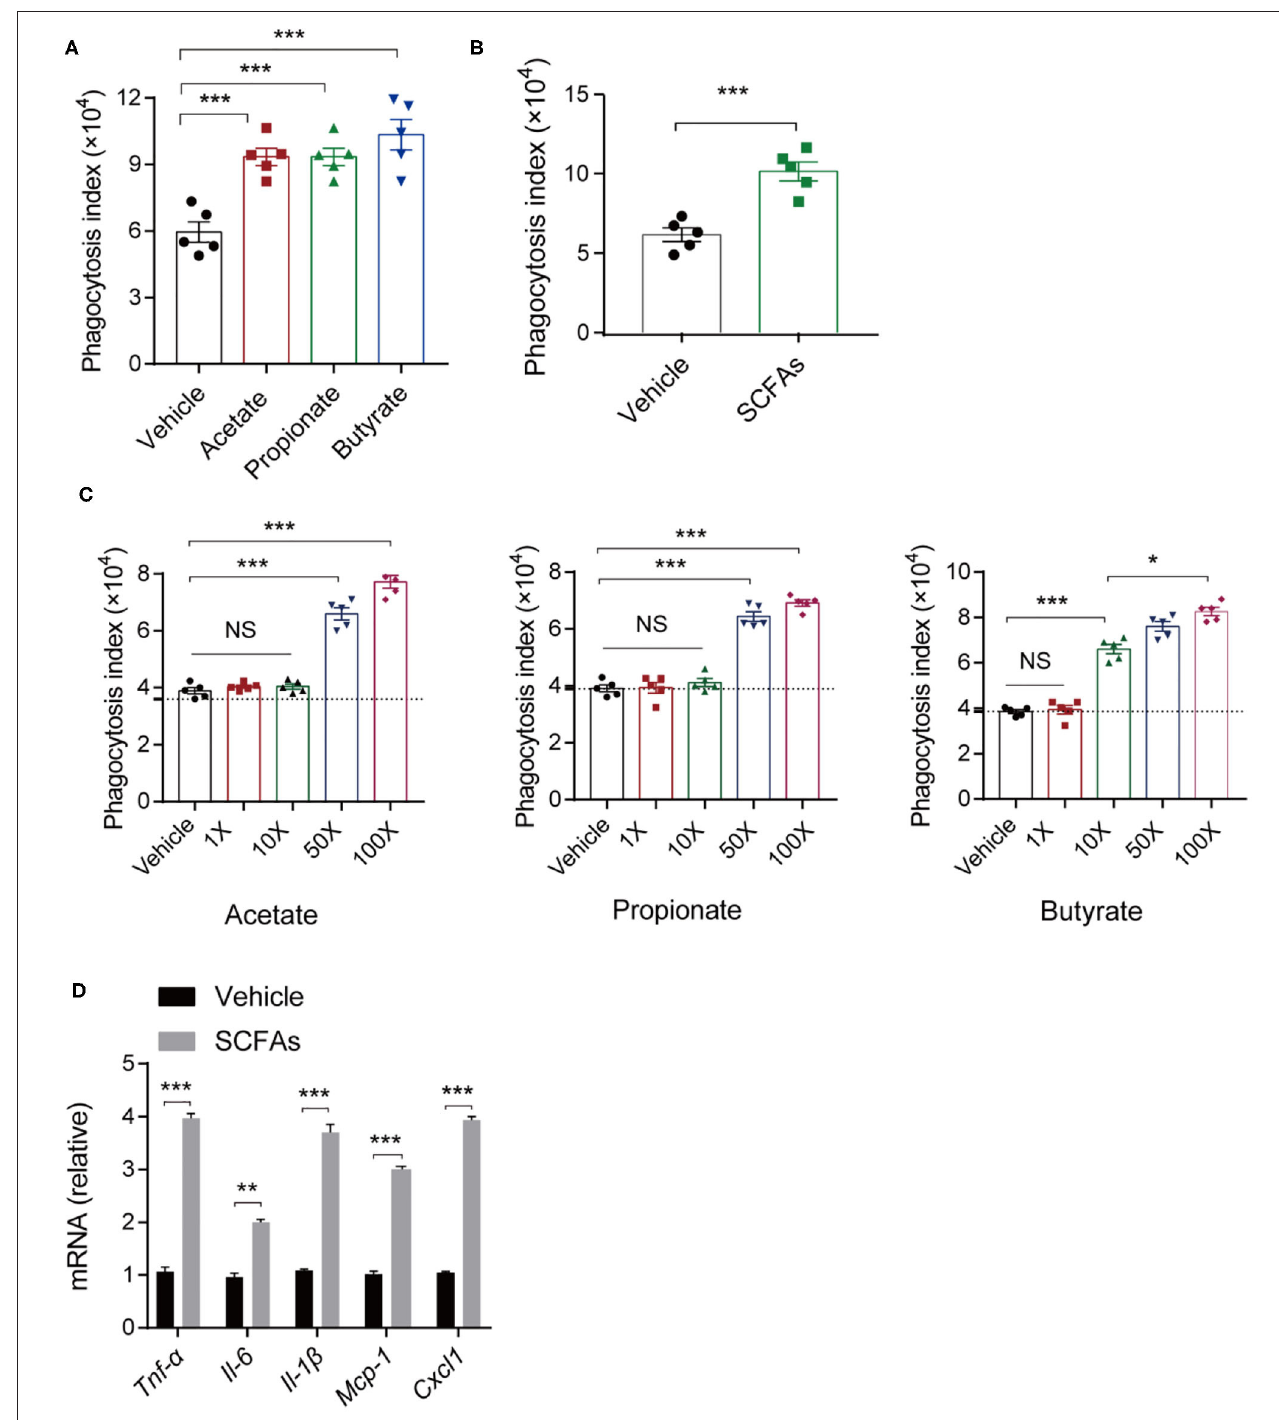
FIGURE 6 | In vitro and in vivo analyses of macrophage phagocytosis of K. pneumoniae . (A) Phagocytic capacity of different SCFA-treated mice and untreated controls post K. pneumoniae infection. (B) Phagocytic capacity of isolated alveolar macrophages from 150-mM SCFA-treated mice and untreated controls. (C) Phagocytic capacity of different concentrations of SCFA-treated RAW264.7 and untreated controls (1 × acetate: 200 µ m, 1 × propionate: 5 µ m, 1 × butyrate: 5 µ m). (D) RT-qPCR analysis of Tnf- α , Il-6 , Il-1 β , Mcp-1 , and Cxcl1 mRNA expression in SCFA mixture-treated RAW264.7 cells and untreated controls 6h post K. pneumoniae infection (MOI = 10). Group size is 8–12 per group. Data are from three independent experiments (mean ± s.e.m) (A–D) . P- values are determined using two-tailed Student’s t -tests (B,D) or one-way ANOVA for multiple comparisons (A,C) . * P < 0.05, ** P < 0.01, *** P < 0.001. NS, not significant.